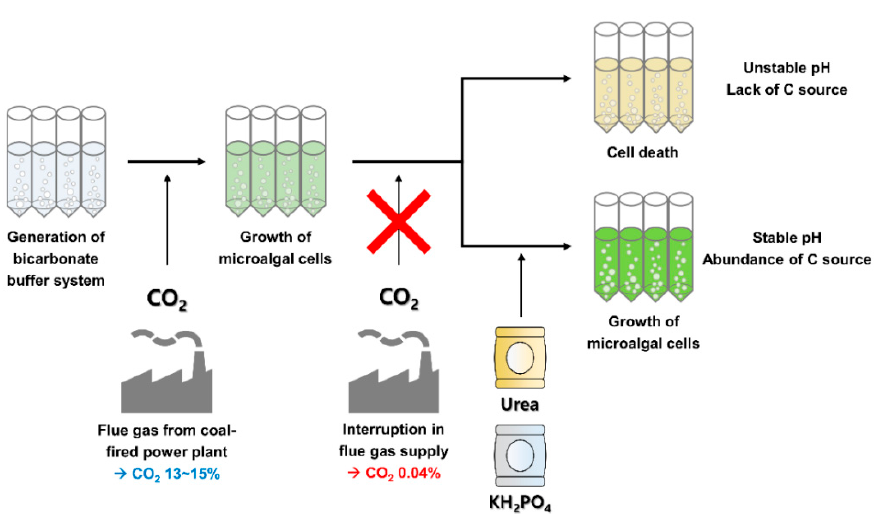
Figure 1. Injection of chemical fertilizers, such as cost-effective urea ($1.93 kg − 1 ; 57-13-6 from DUKSAN science) and KH 2 PO 4 ($44.69 kg − 1 ; 7778-77-0 from DUKSAN science), to improve microalgal biomass production upon interruption of CO 2 supply.